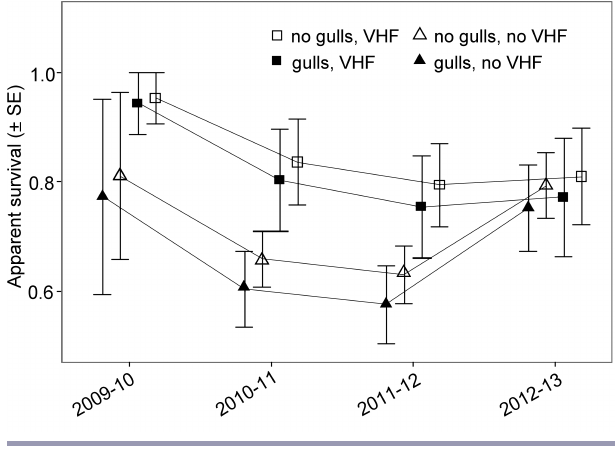
Fig. 2 . Model-averaged annual survival estimates (± SE) from 2009 to 2013 for adult Leach’s Storm-petrels (Oceanodroma leucorhoa) on Bon Portage Island, Nova Scotia, Canada. No estimate is given for 2013-2014 because only a return rate can be estimated for the final interval. Birds were grouped into those nesting in plots with or without Herring Gulls and with or without VHF tags. Note that the particularly large SEs in 2009-2010 are because of small sample sizes of storm-petrels banded in